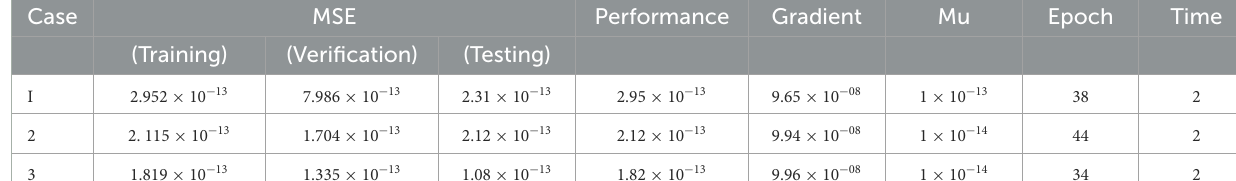
TABLE 3 ANN-LBVMBP method for the HBVNS XYWRZ model.